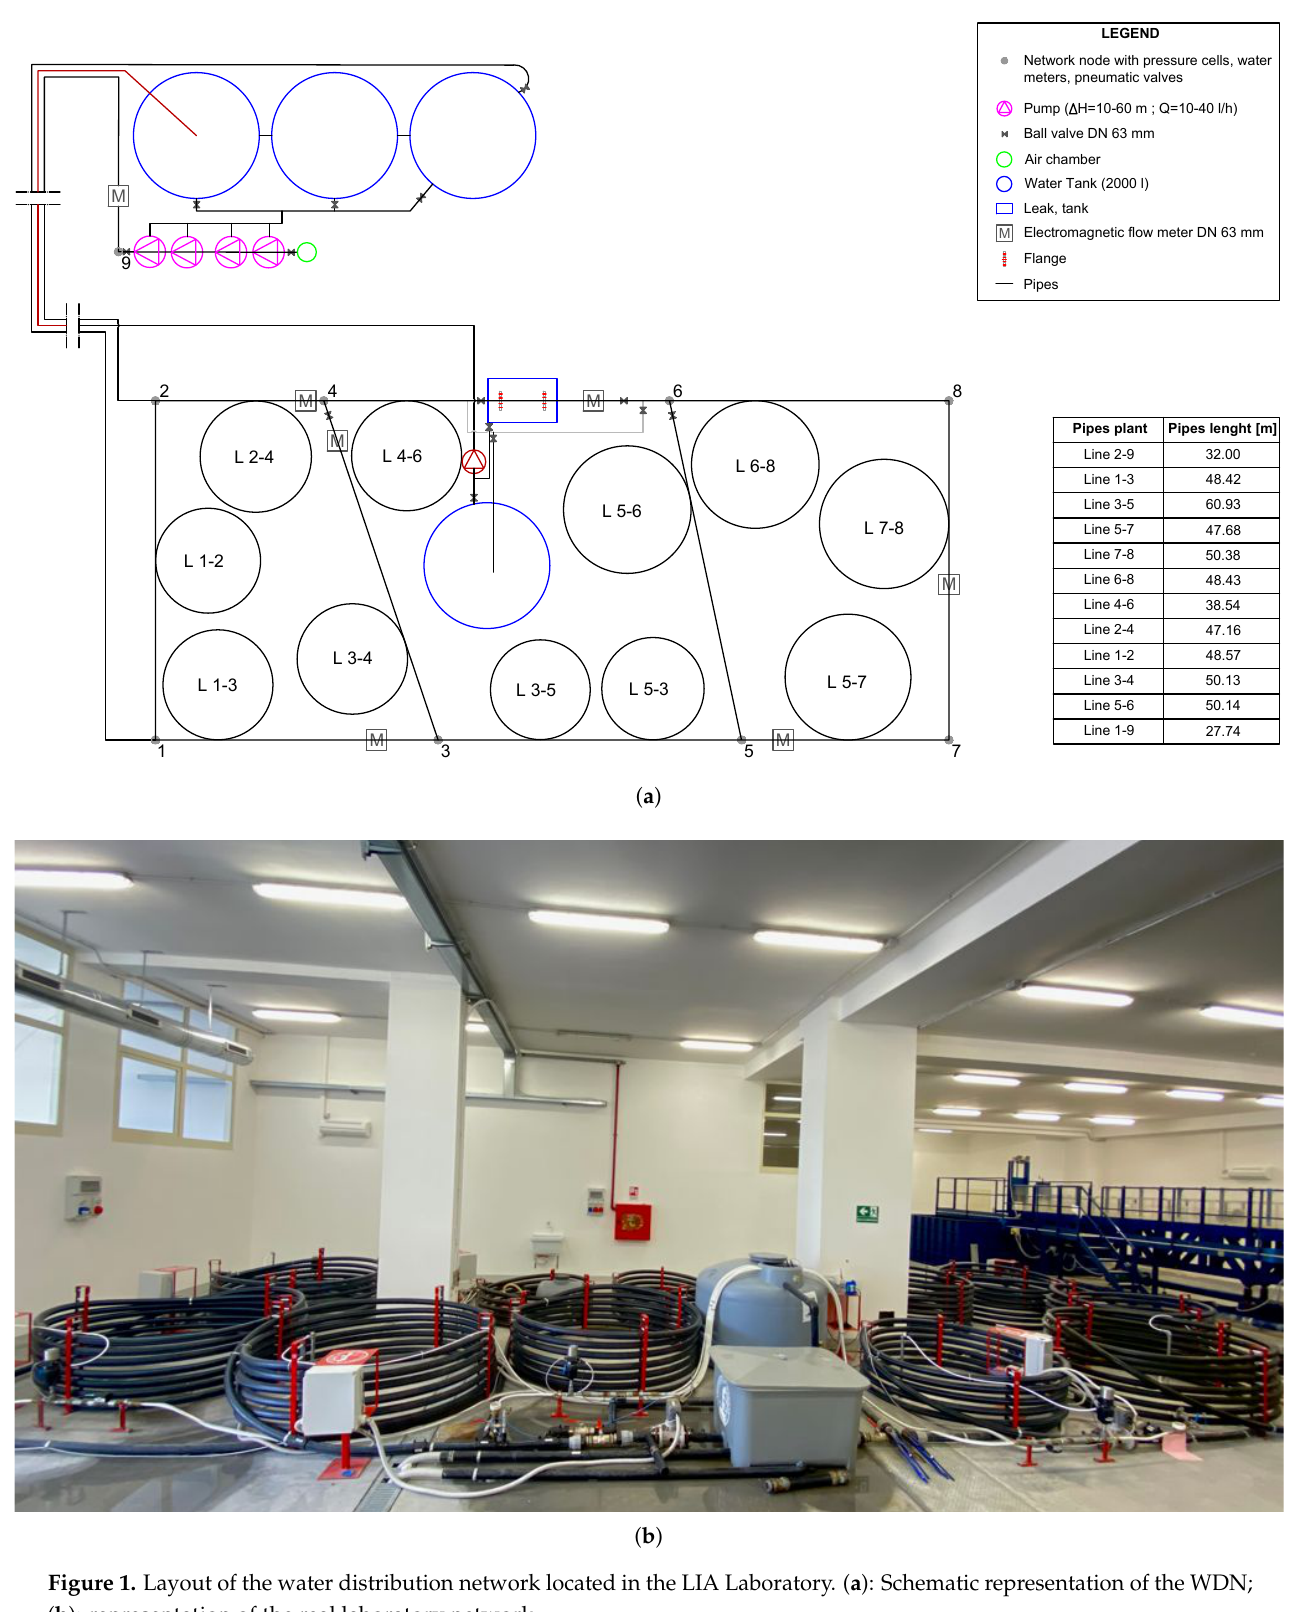
Figure 1. Layout of the water distribution network located in the LIA Laboratory. ( a ): Schematic representation of the WDN; ( b ): representation of the real laboratory